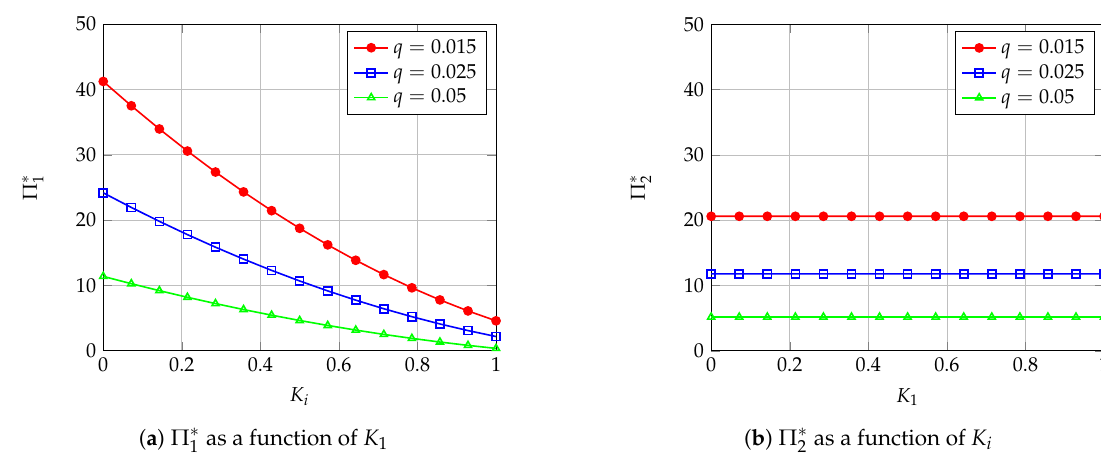
Figure 8. MNOs profits as a function of K 1 and K 2 = 0.45.